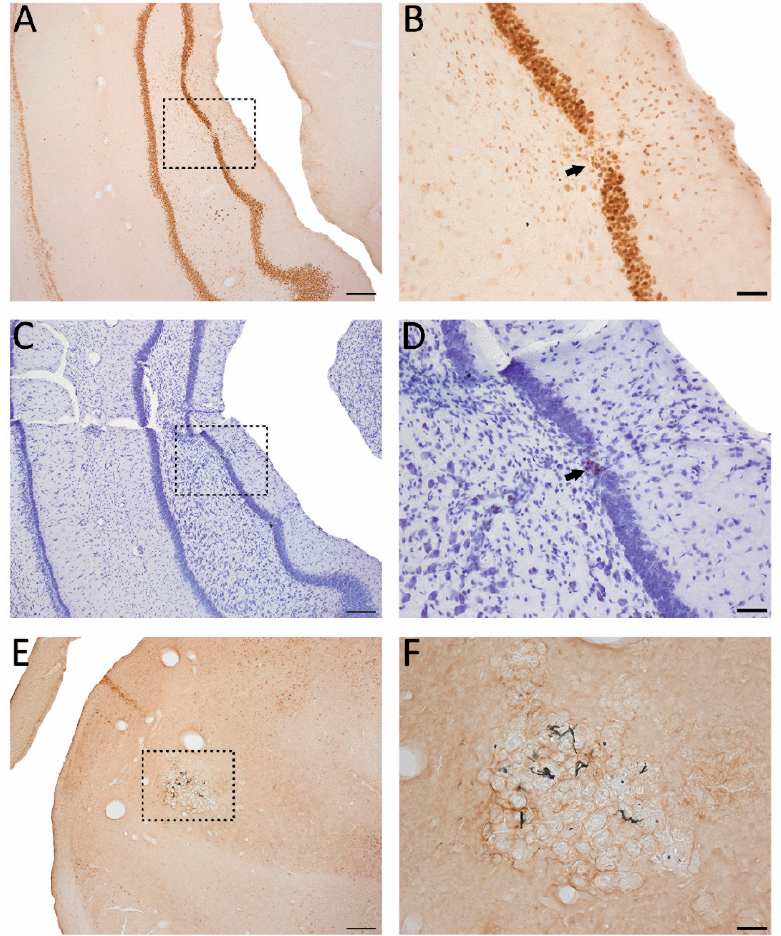
Figure 12. Pattern of c-Fos expression in the dentate gyrus. Representative photomicrographs showing mild granule cell damage and dispersion in the dentate gyrus ( A – D ) and calcifications in the